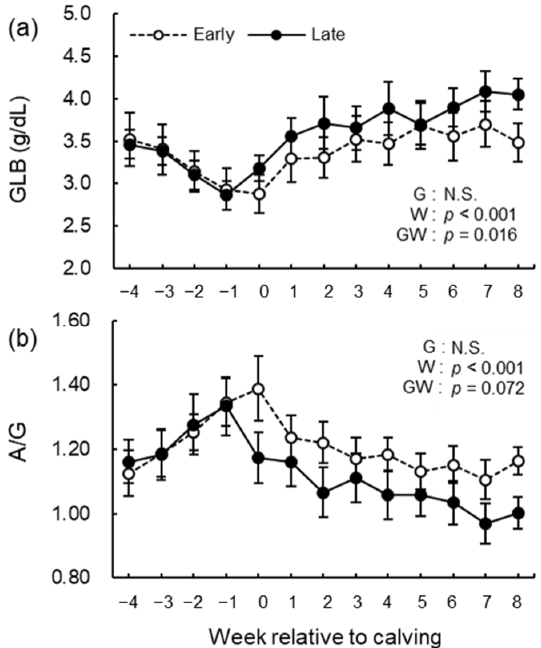
Figure 11. Serum concentrations of ( a ) globulin (GLB) and ( b ) albumin/GLB (A/G) from −4 to 8 wk relative to calving for cows classified into the early group (Early) and the late group (Late). Early = cows with endometrial inflammation converged within 4 wk, n = 17; Late = cows with endometrial inflammation converged at or after 5 wk, n = 16. The week of calving is defined as 0 wk. G = group effect; W = week effect; GW = group-by-week interaction. Data are shown as mean ± SEM.